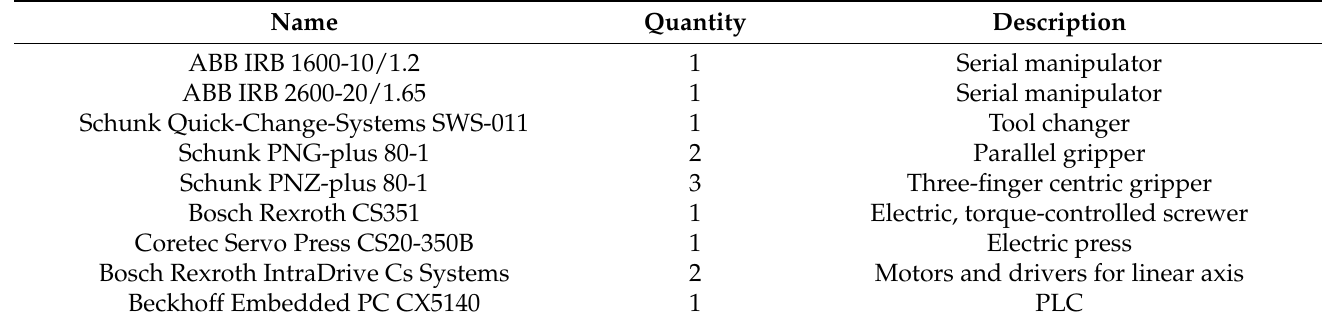
Table 1. Details on the main devices employed in the cell.